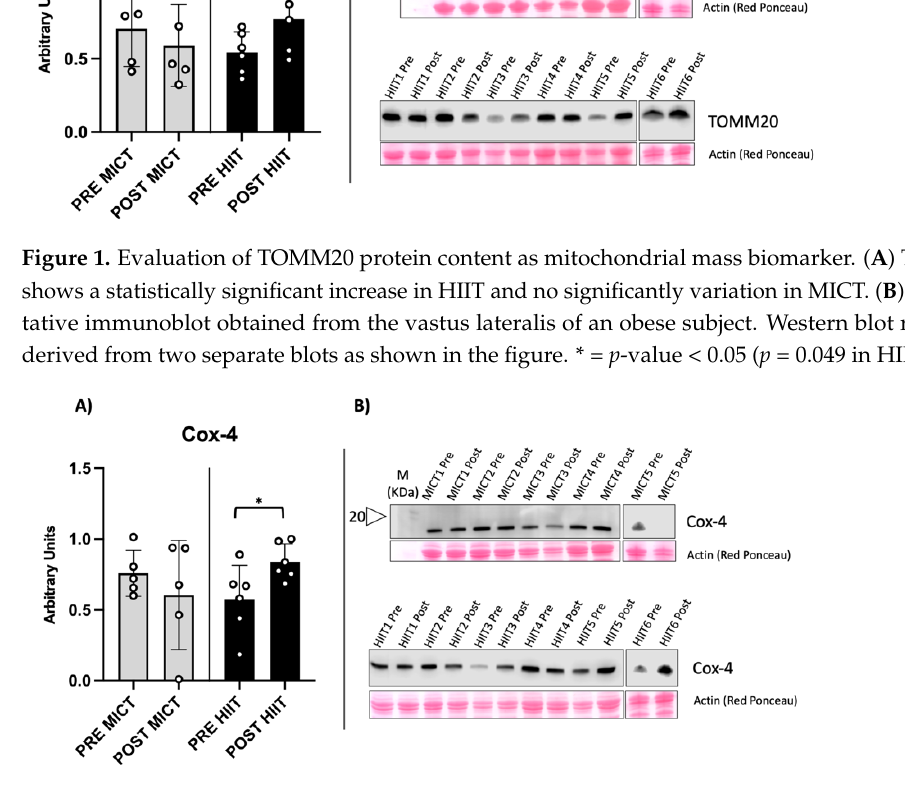
Figure 2. Evaluation of Cox ‐ 4, component of electron transport chain, as mitochondrial functionality biomarker. ( A ) The graph shows a statistically significant increase in HIIT and unchanged variation in MICT. ( B ) Representative immunoblot obtained from the vastus lateralis of an obese subject. Western blot results are derived from two separate blots as shown in the figure. * = p ‐ value < 0.05 ( p = 0.039 in HIIT).